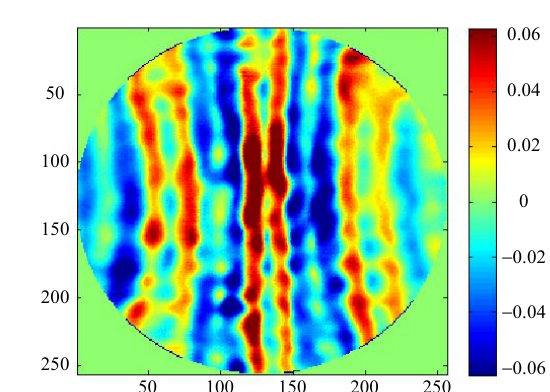
Fig. 11 RMS of the restoration phase difference with two methods.